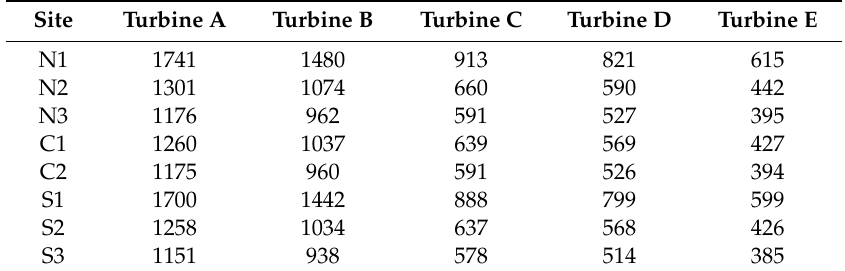
Table 5. Average number of turbines estimated to cover the air pollution generated by Constanta Port activities. The results are indicated for the 20-year time interval of